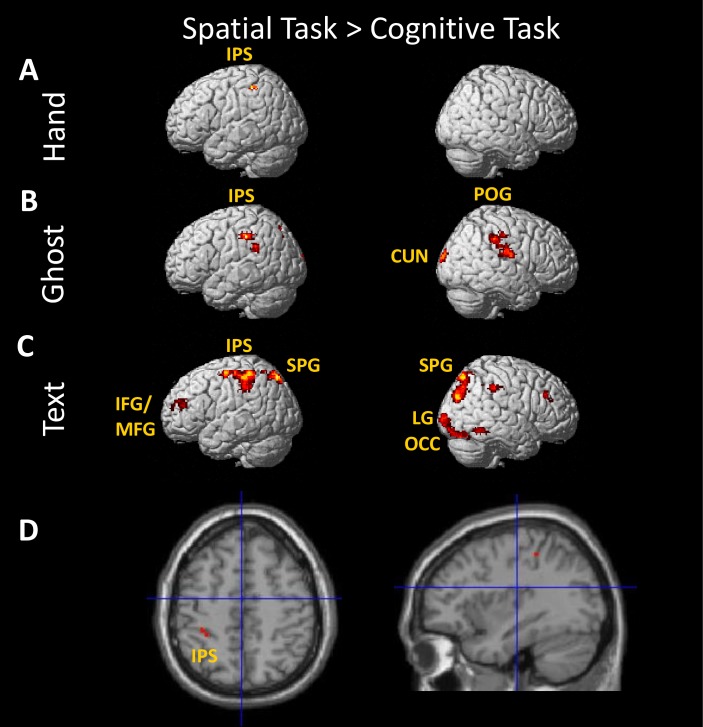
Simple effects of viewing demonstrations of the spatial task compared to the cognitive task for each of the three demonstration types: Hand (A), Ghost (B), and Text (C). (D) Conjunction of the three contrasts shown above. The coordinates of the area activated in all three conditions are −35 −36 50. Coordinates for all clusters are given in Table 2. Abbreviations: CUN, cuneus; IFG/MFG, inferior frontal gyrus/middle frontal gyrus; IPS, intraparietal sulcus; LG, lingual gyrus; OCC, occipital gyrus; PCUN, precuneus; POG, postcentral gyrus; SPG, superior parietal gyrus. Clusters of activation in the precuneus (Ghost) and right caudate nucleus, left putamen, and right cerebellum (Text) are not visible in this depiction.